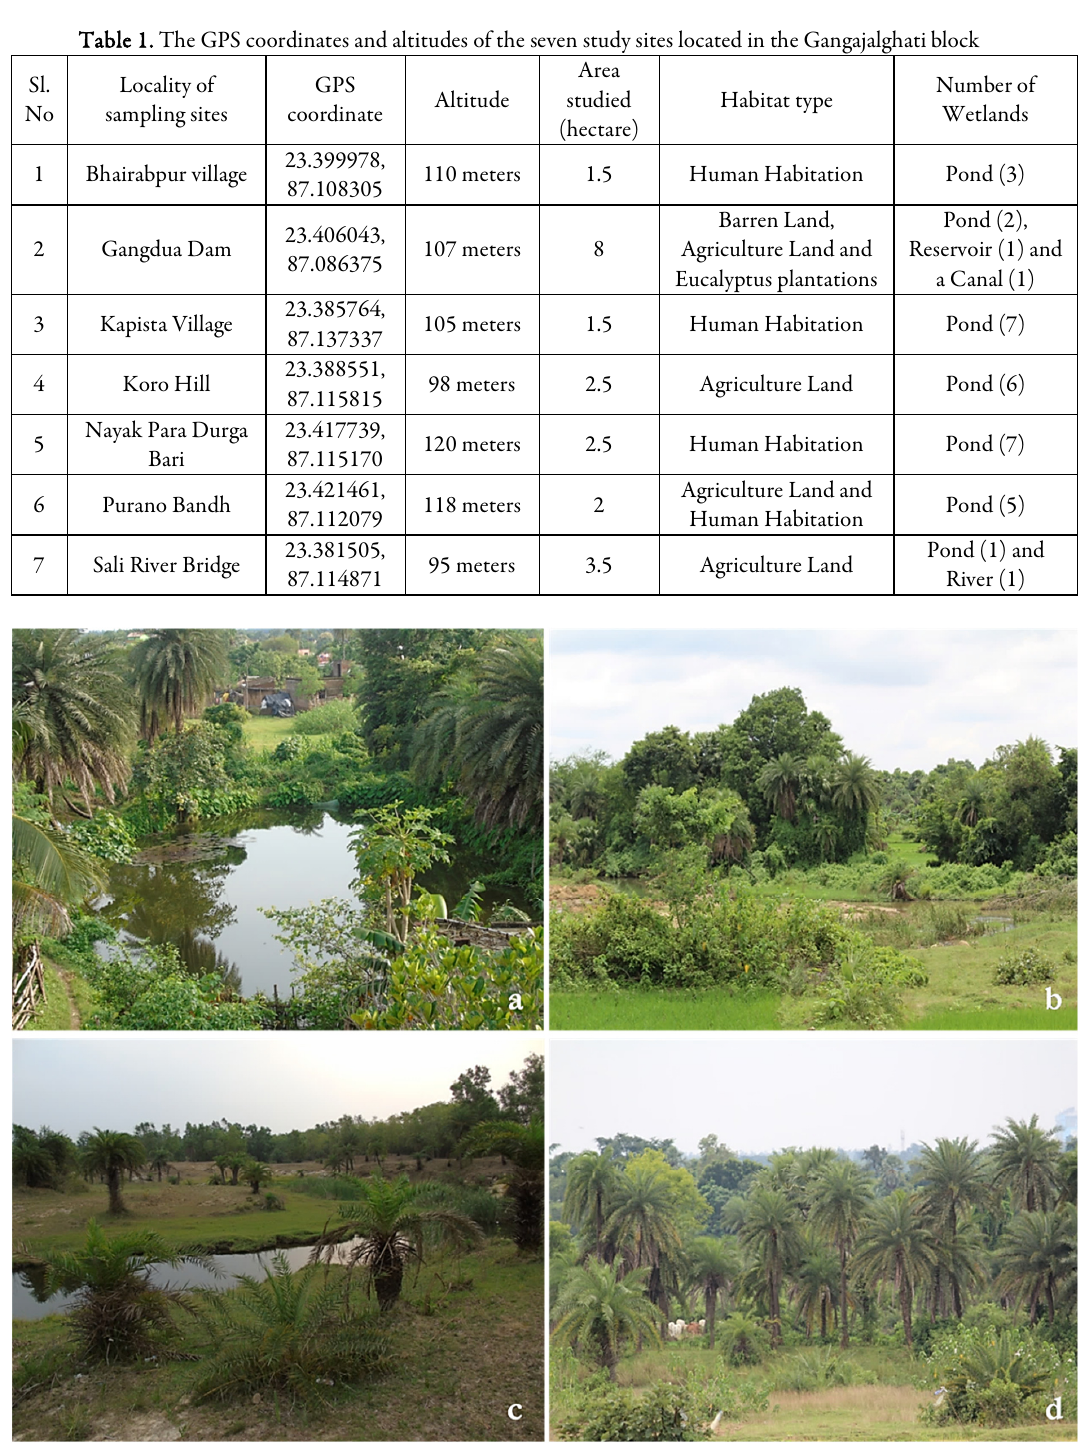
Figure 2. Different types of habitats found within the study area, Gangajalghati block a. A pond surrounded by Indian date palm trees in Gangajalghati village; b. Vegetation around Sali river; c. Habitat around Gangdua dam & d. A colony of Phoenix sylvestris near Koro